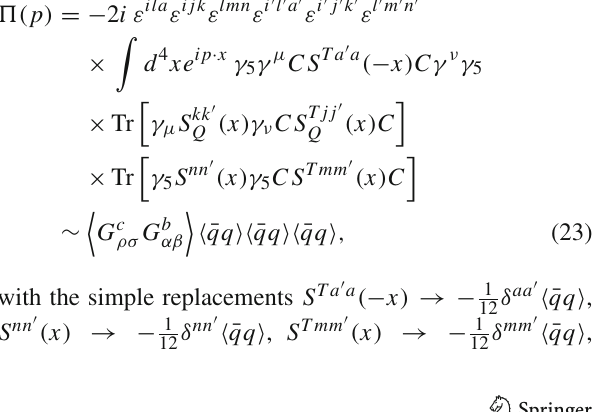
into account the vacuum condensates at least up to dimension 7. For the correlation functions (cid:12)( p ) , (cid:12) μν ( p ) and (cid:12) μναβ ( p ) of the doubly heavy five-quark currents, there are two heavy quark propagators and three light quark propagators, if